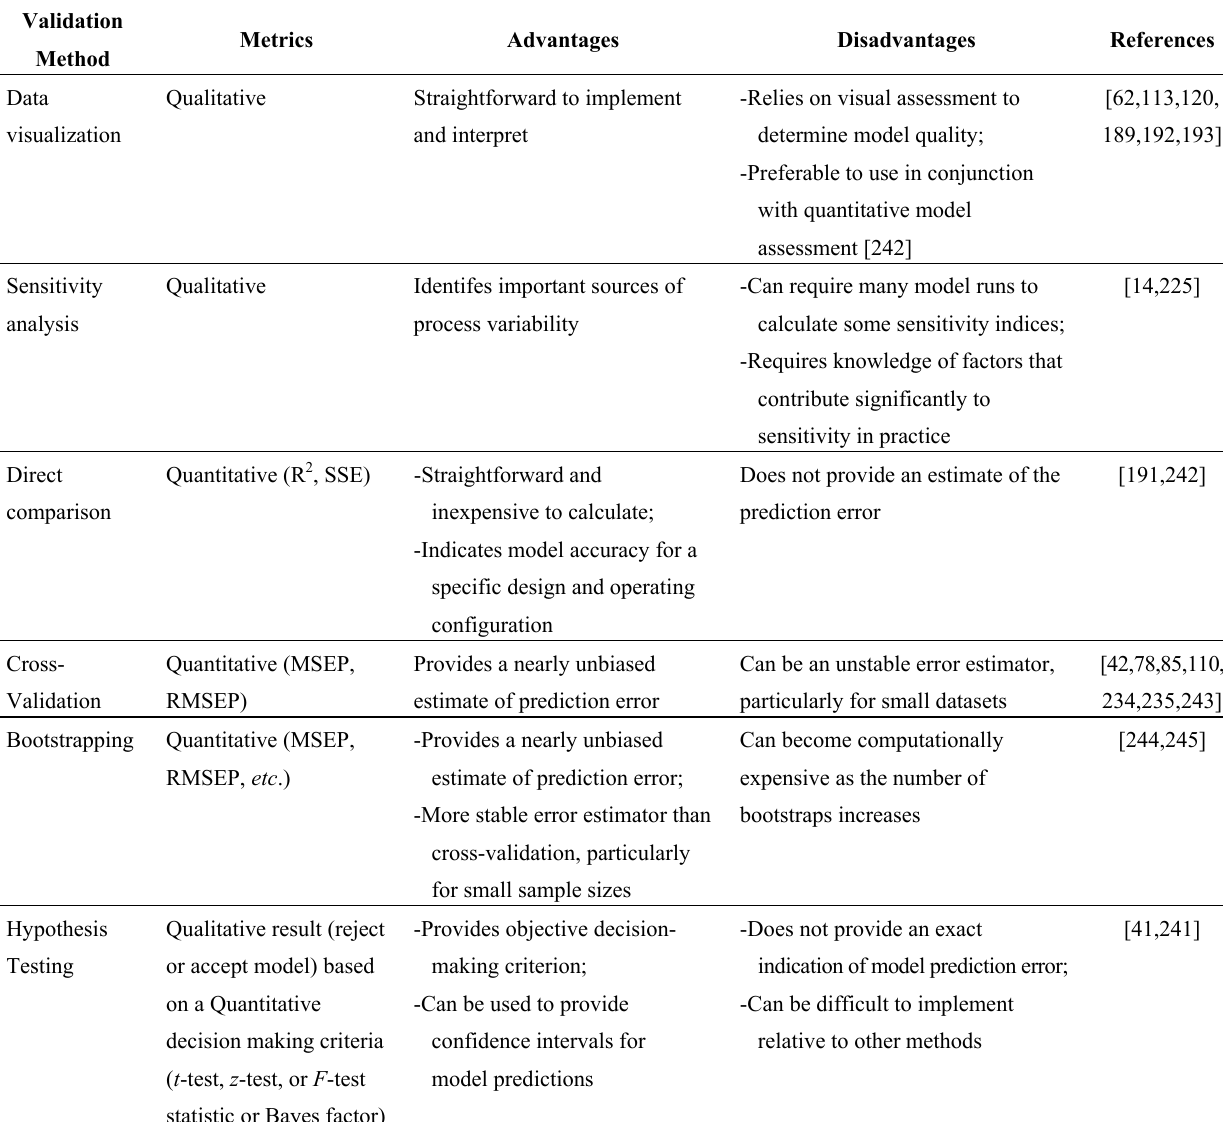
Table 4. Summary of validation methods discussed in the current work, including references in which the proposed validation methodology is